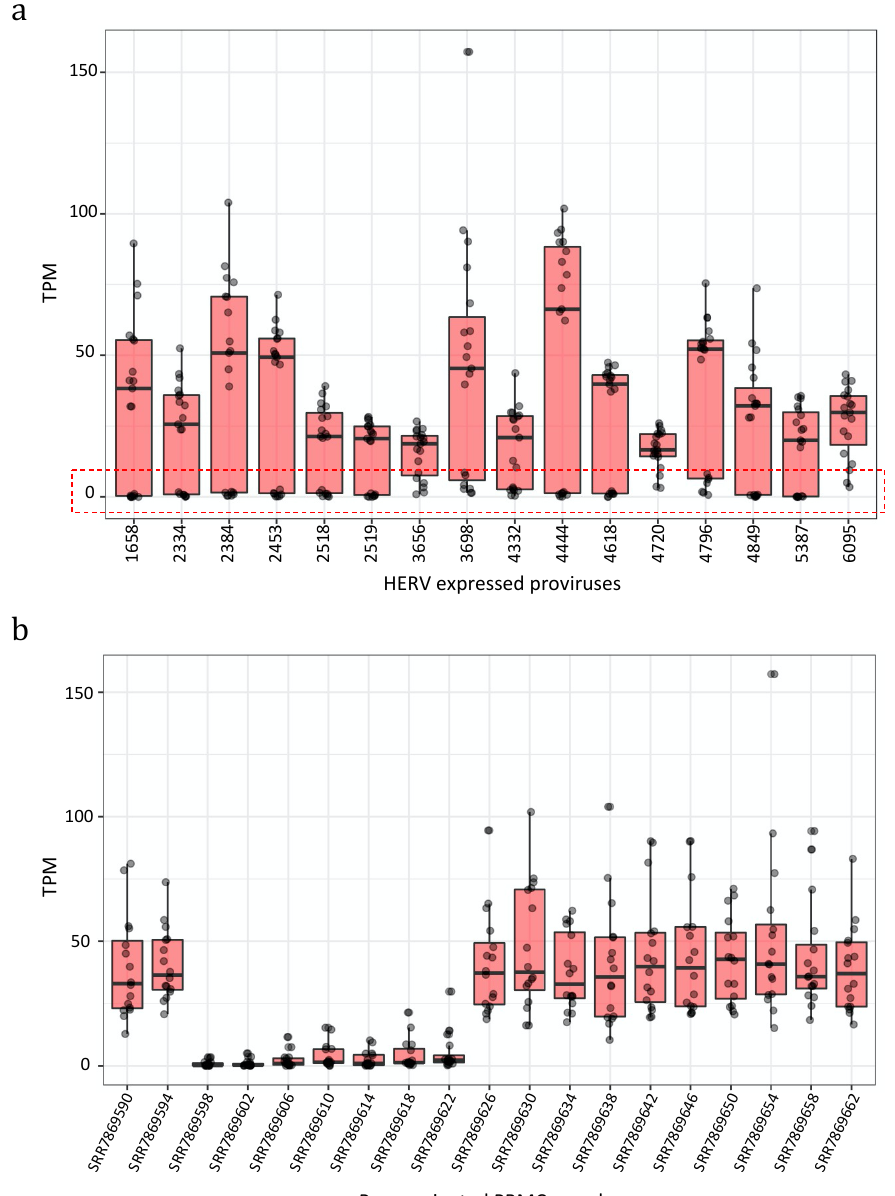
Figure 2. Expression values of the 16 most expressed proviruses. Boxplot of the expression values (measured as TPMs) of the 16 proviruses with the highest expression. ( a ) All proviruses showed a strong interpersonal variability being lowly or not expressed in some samples (red box). ( b ) We hence assessed the expression of the 16 proviruses among the individuals, finding 7 of them where the HERVs were not or only lowly expressed.